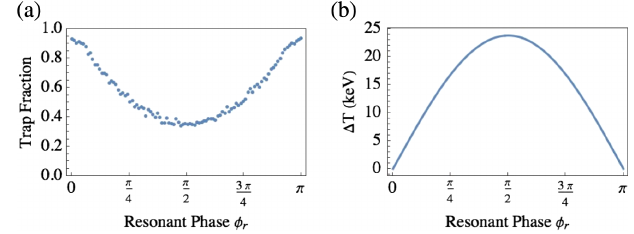
FIG. 6. Predicted trapping fraction (a) and total energy gain (b) as functions of resonant phase ϕ